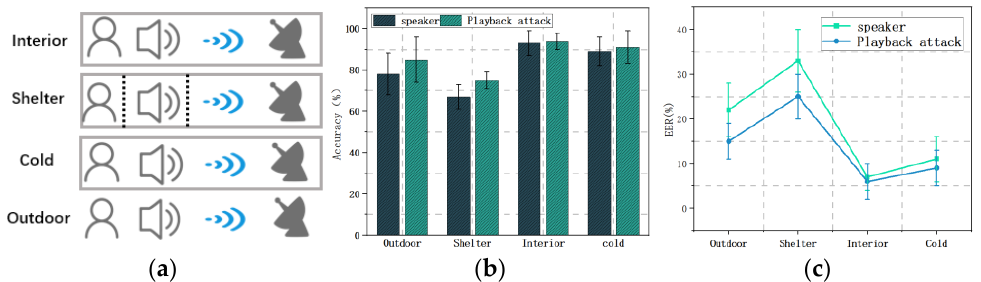
Figure 12. Speaker status dimension: ( a ) Experimental schematic of the speaker state dimension; ( b ) accuracy; ( c ) EER.